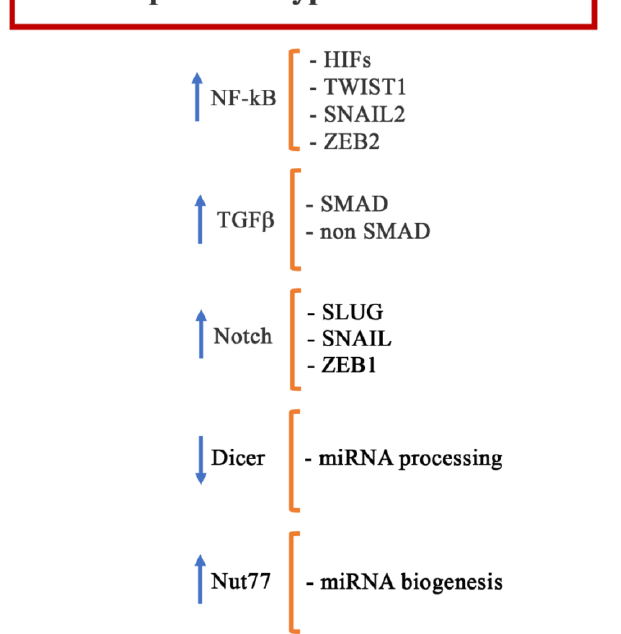
Figure 5. Regulation of EMT-related actors by hypoxia in a HIF-independent way. Transcription factors (NF-kB), growth factors (TGF β ), membrane receptors (Notch), and miRNAs can be modu- lated during hypoxia to control